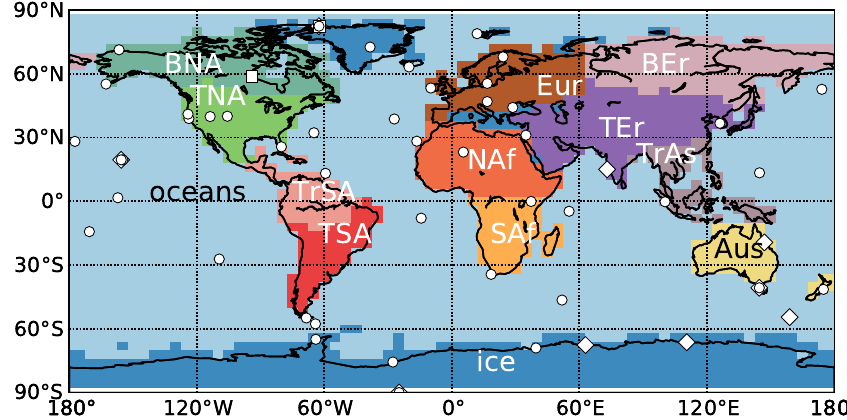
Figure 1. Distribution of the 13 geographical regions for which we estimate CO 2 and CH 4 fluxes, and the location of 57 co-operative flask sampling sites with data covering the study period, January–December 2010. The land regions, informed by previous work (Gurney et al., 2002), include Boreal North America (BNA), Temperate North America (TNA), Tropical South America (TrSA), Temperate South America (TSA), Northern Africa (NAf), Southern Africa (SAf), Boreal Eurasia (BEr), Temperate Eurasia (TEr), Tropical Asia (TrAs), Australasia (Aus), and Europe (Eur). The ground-based measurement sites run by NOAA ESRL, CSIRO GASLAB, and EC are denoted by white circles, white diamonds, and white squares, respectively.